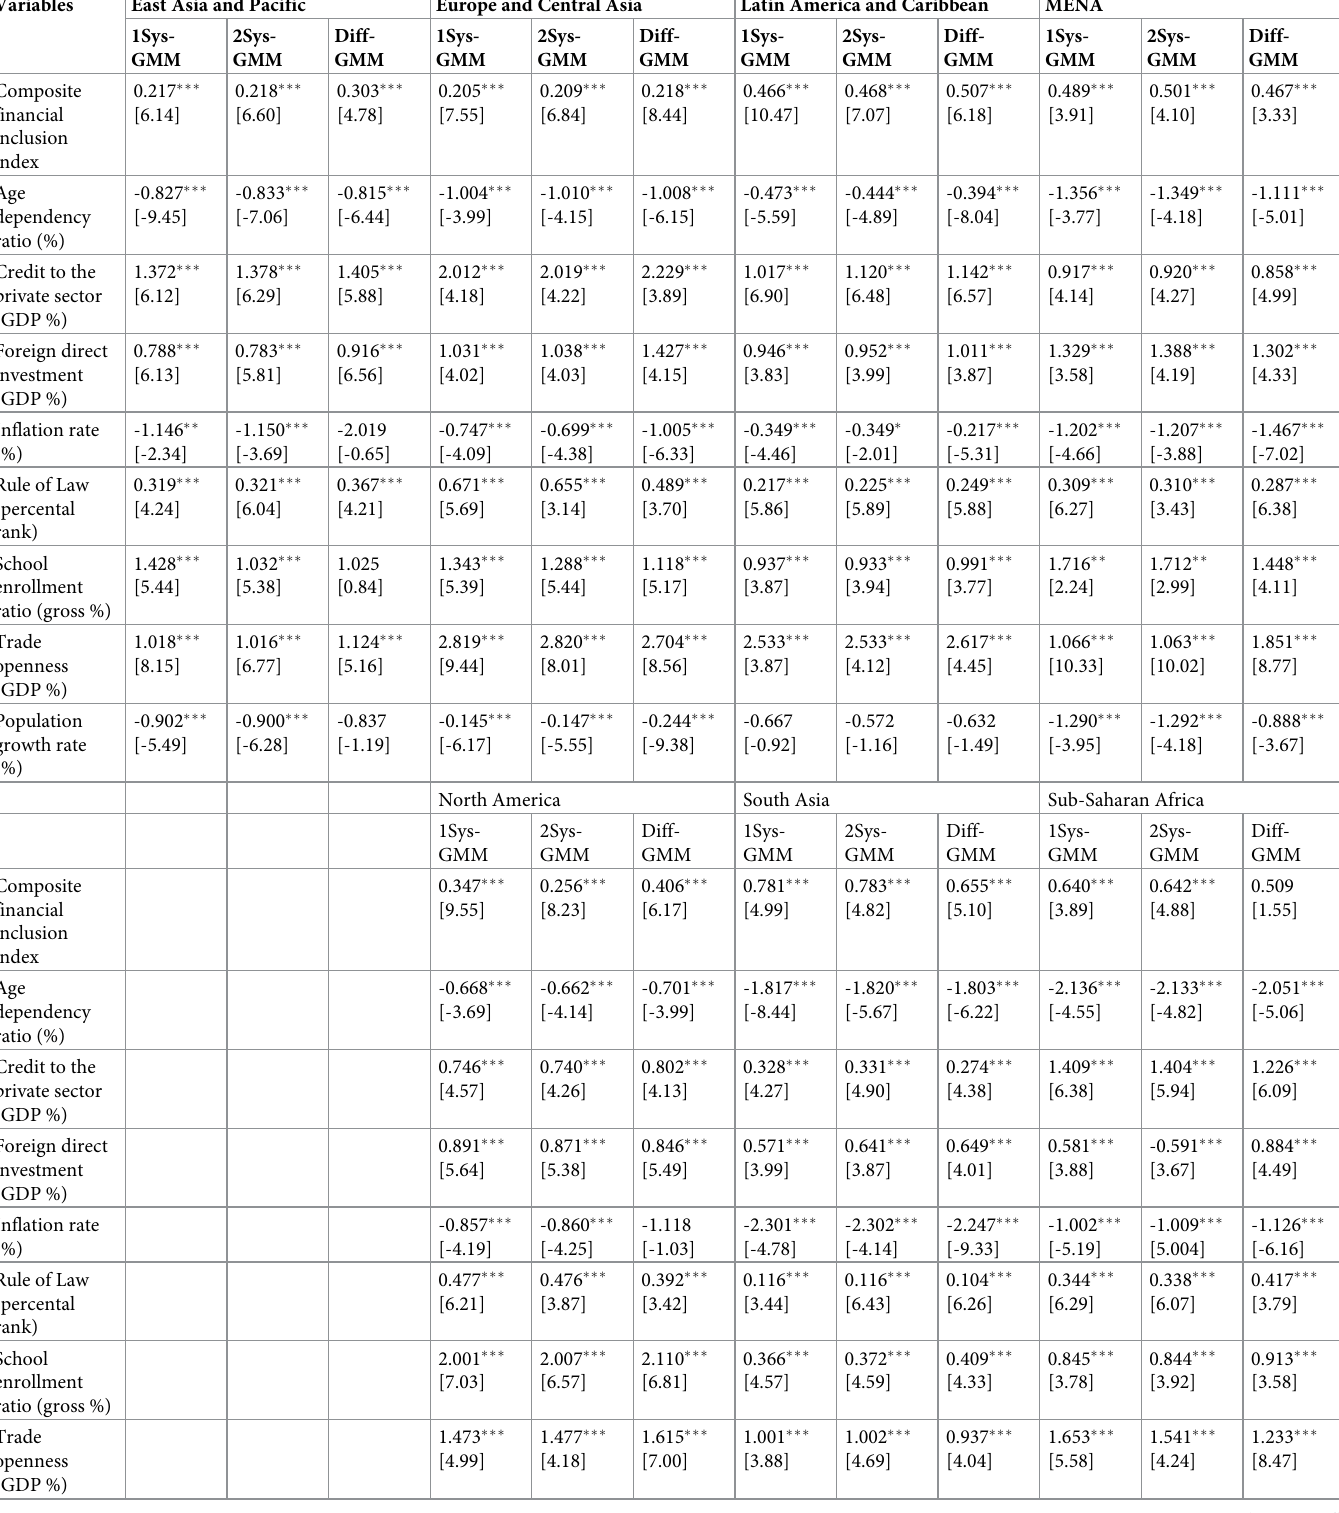
Table 4. Results of the GMM estimates for regional